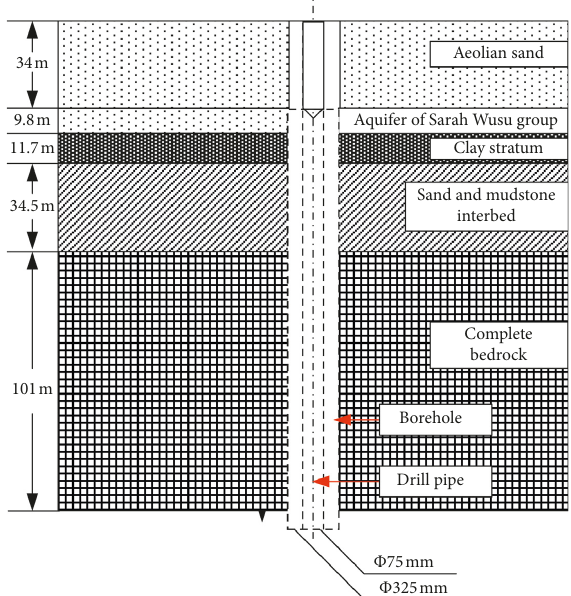
Figure 8: Cutaway view of sediment-water flow model.